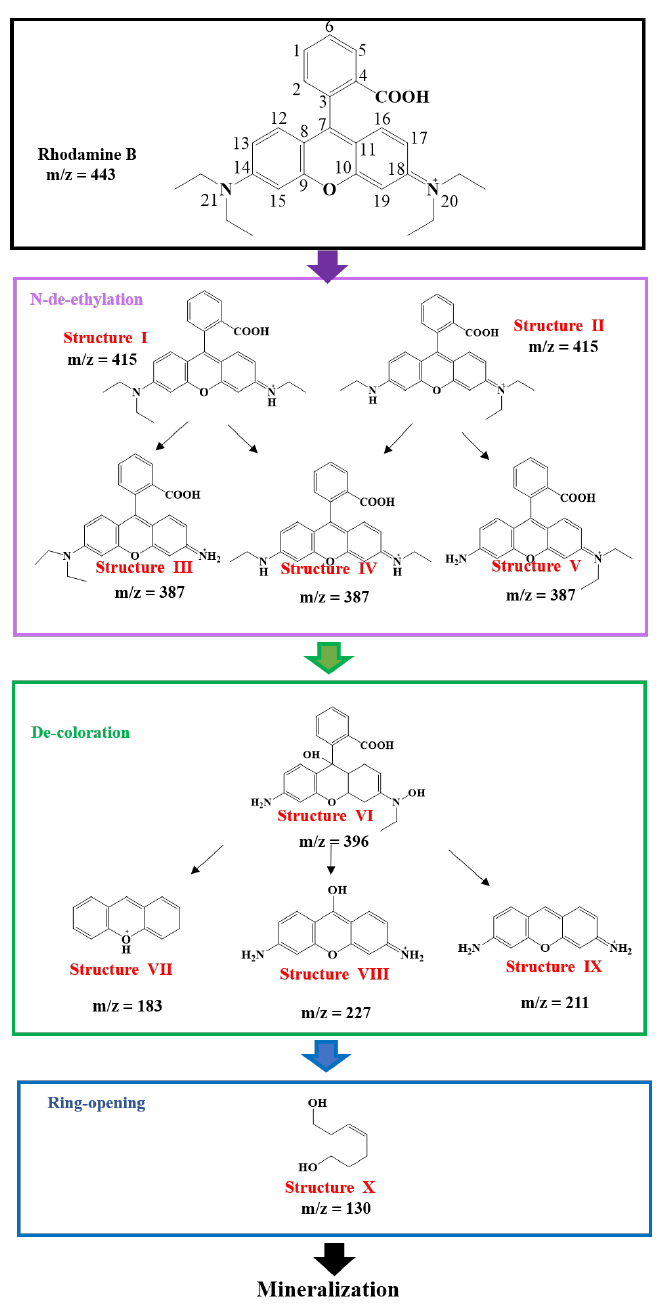
Figure 6. Possible pathway for the photocatalytic degradation of RhB in HYPs/H 2 O 2 PAOP.